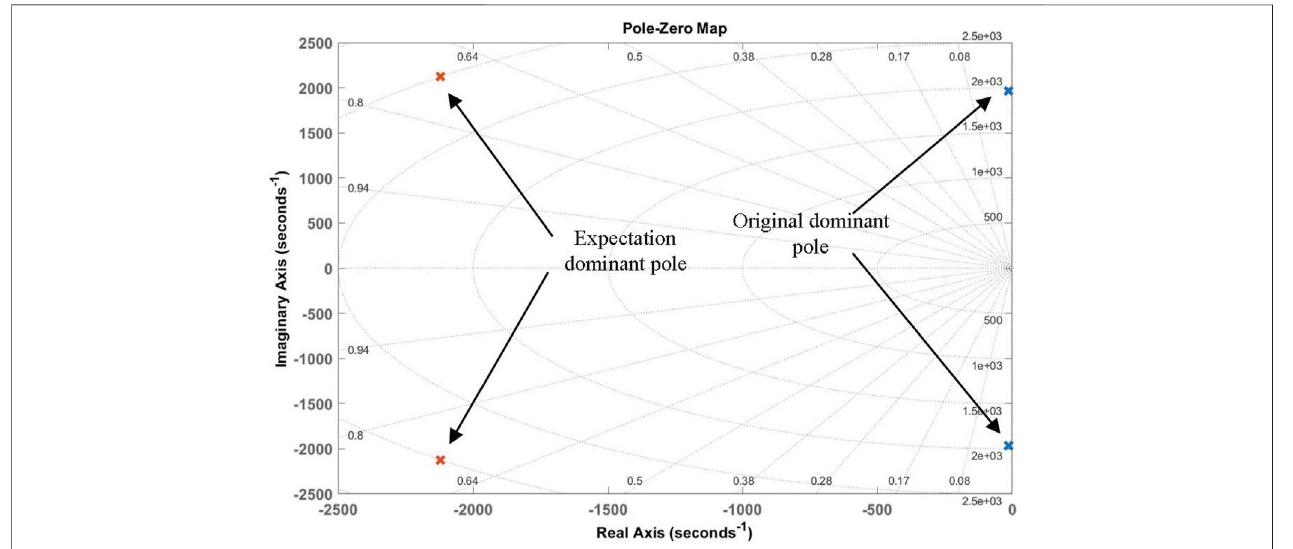
FIGURE 7 | The original dominant pole and the expectation dominant pole.